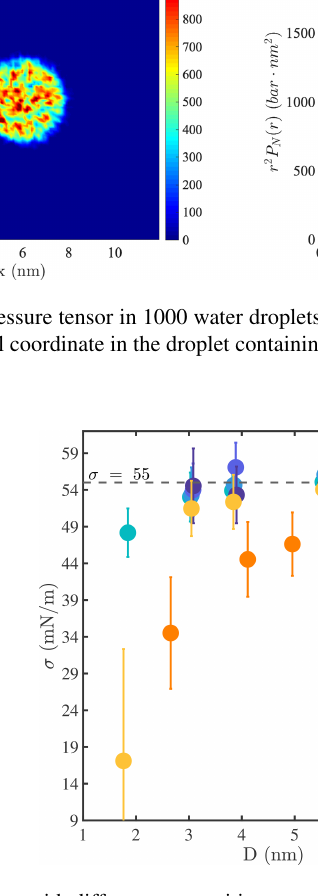
Figure A12. Surface tension ( σ ) of droplets with different compositions as a function of droplet diameter.